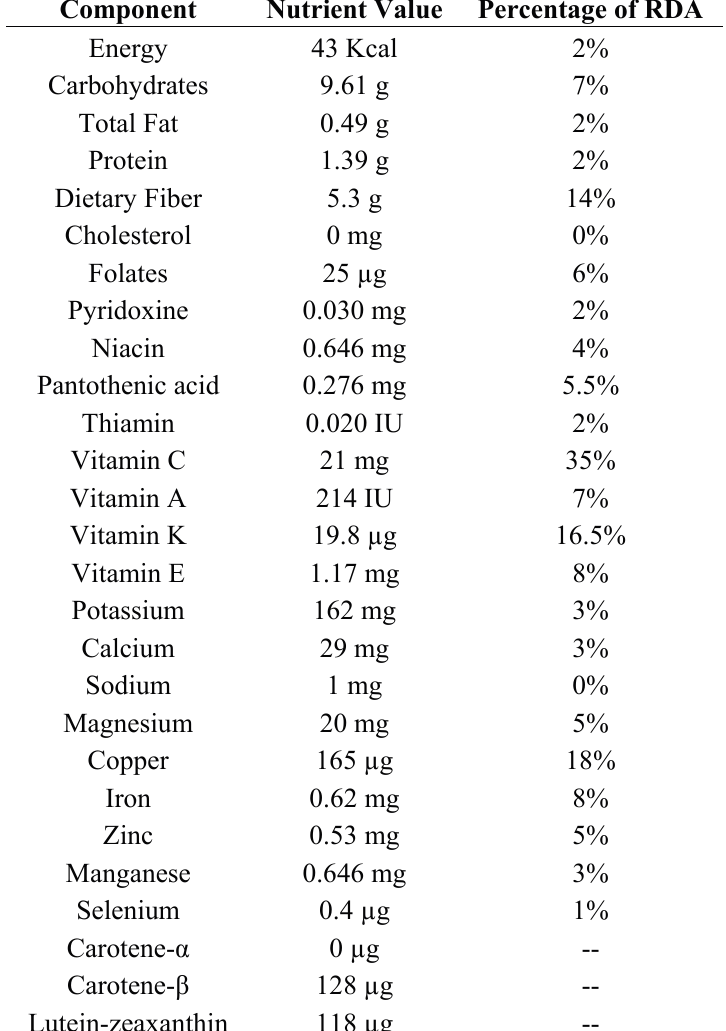
Table 5. Blackberries nutritive value per 100 g [30].